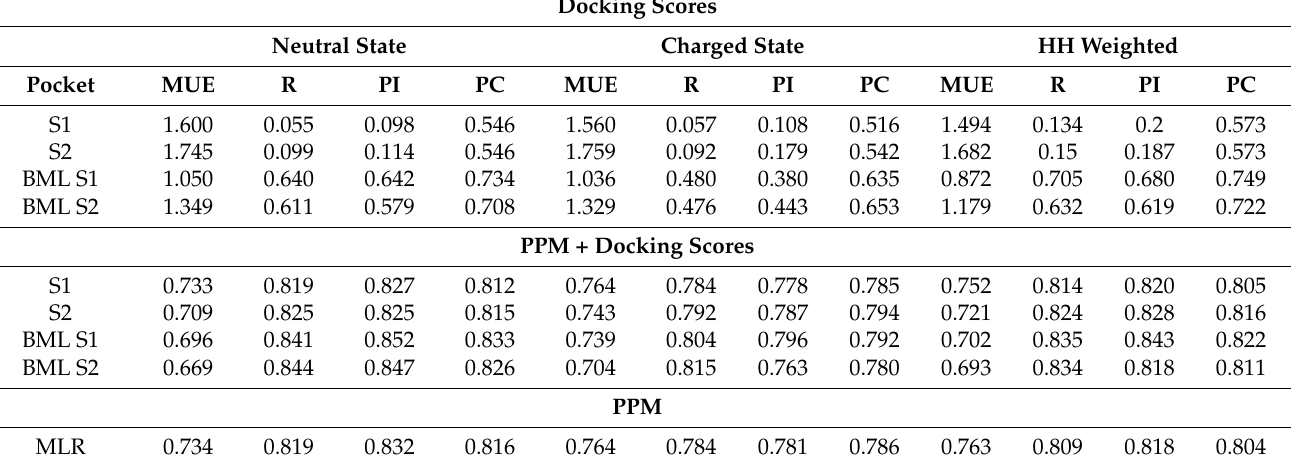
Table 2. Statistical analysis for 55 hERG1 blockers in S1 and S2 binding pockets for neutral, charged, and HH-weighted scores obtained using the models from the SILCS LGFE scores, PPM, and consensus SILCS-PPM